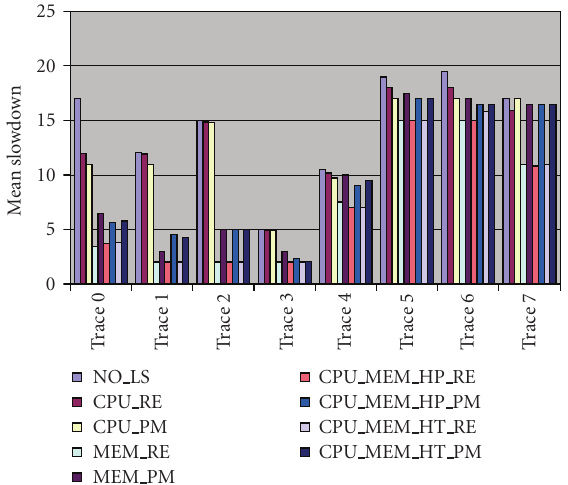
Figure 3: Mean slowdowns of all the 8 traces scheduled by di ff erent load sharing policies with the mean memory demand of